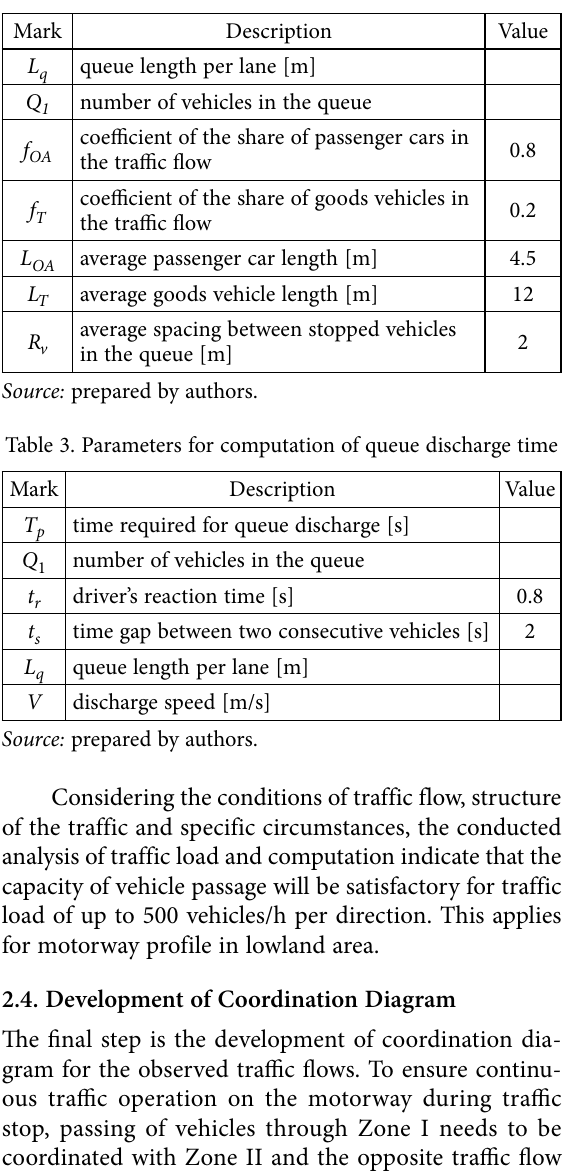
Table 2. Parameters for computation of queue length